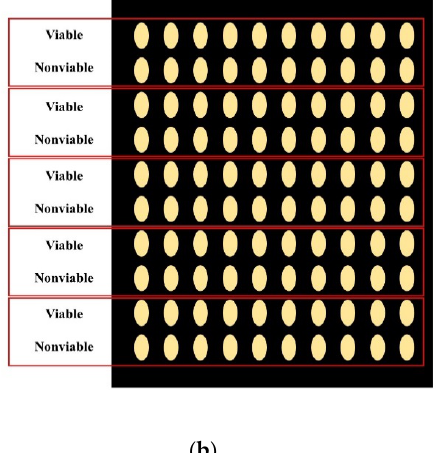
Figure 1. ( a ) Schematic representation of the SWIR-HSI system; ( b ) arrangement of soybean seeds on sample holder plate for HSI scanning.